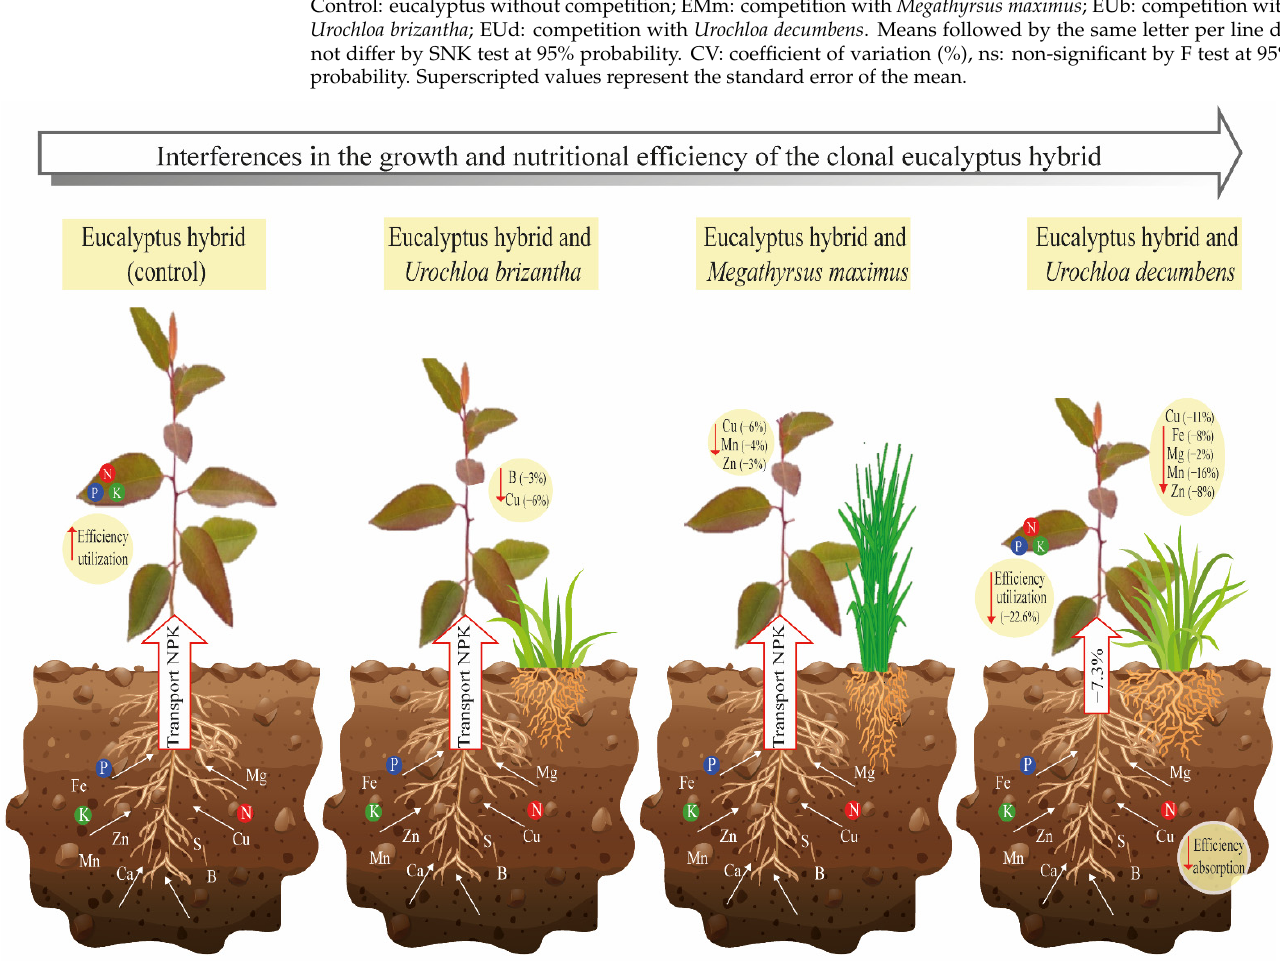
Figure 3. Summary of interferences in the growth and nutritional efficiency of the clonal eucalyptus hybrid I144 ( Eucalyptus urophylla × Eucalyptus grandis